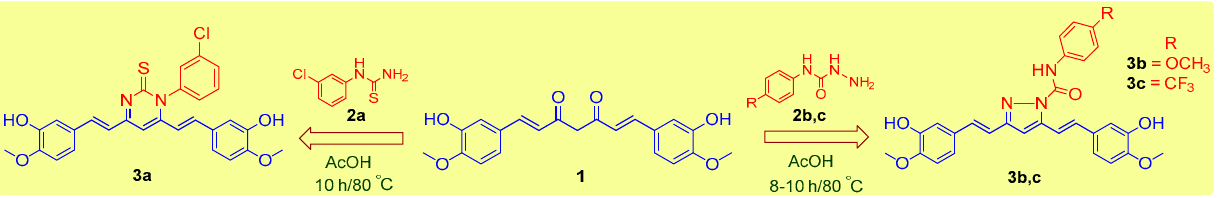
Scheme 1. Molecular engineering for the synthesis of curcumin analogs ( 3a – c ).